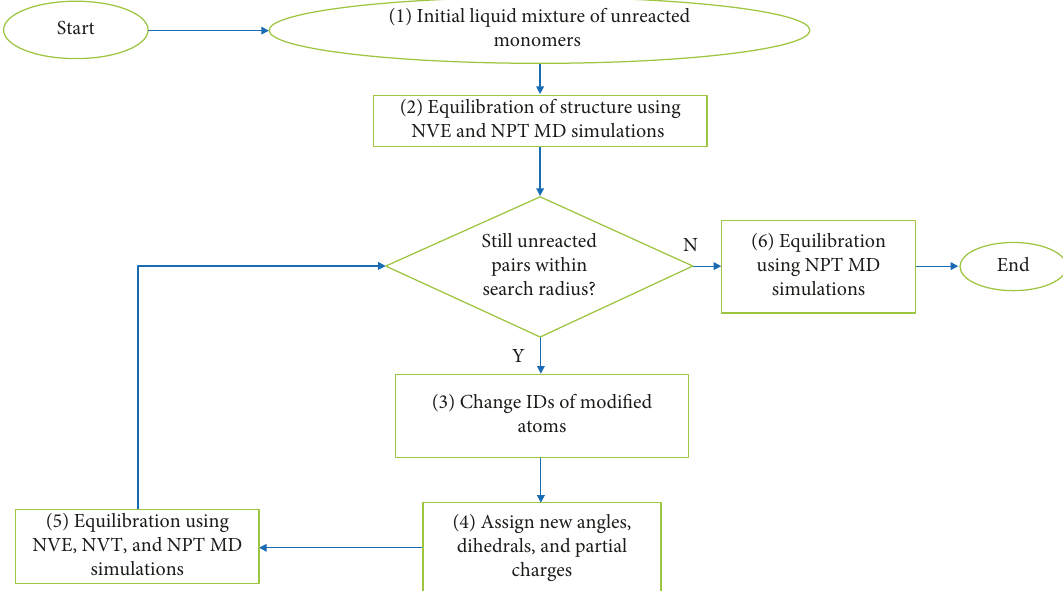
Figure 2: The multistep cross-linking fl